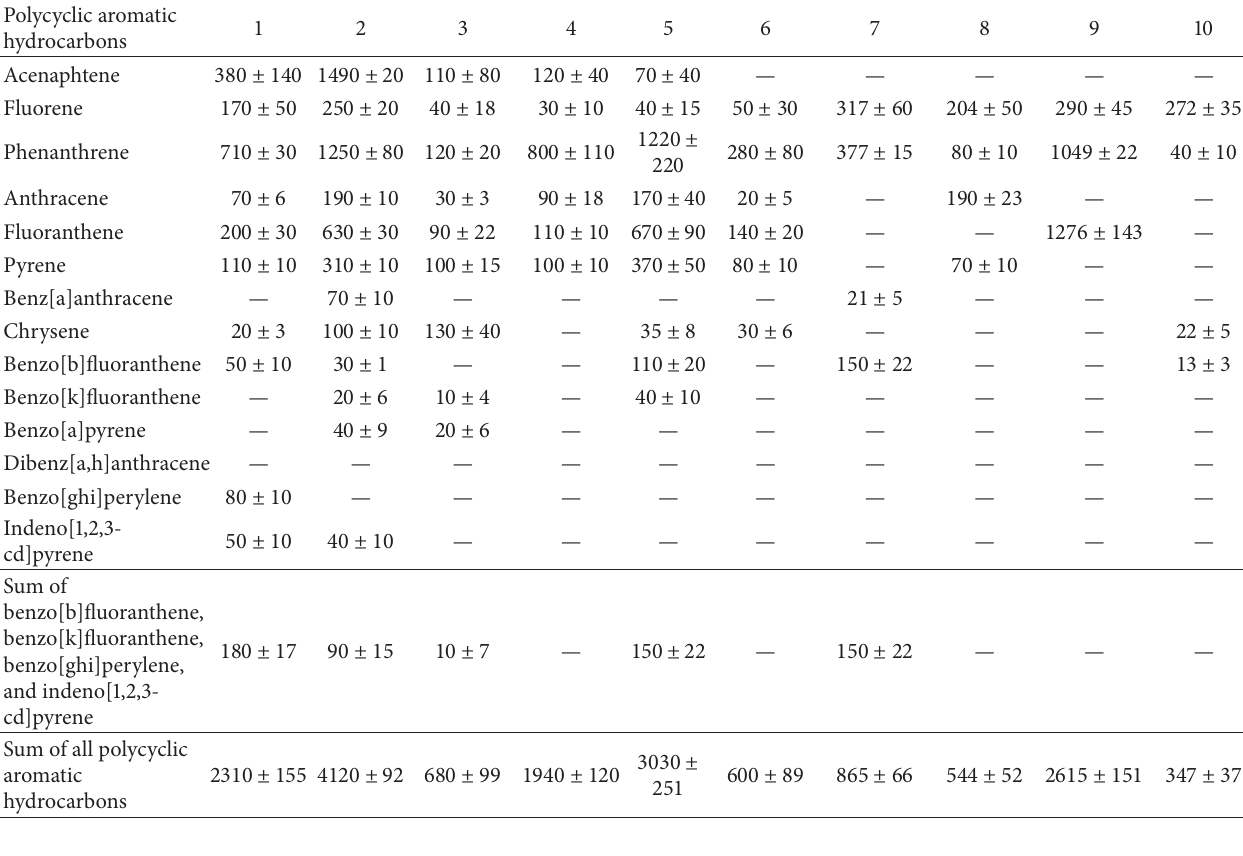
Table 3: Mean polycyclic aromatic hydrocarbons content of black tea infusion samples (ng/L) by saponification followed by liquid-liquid extraction.